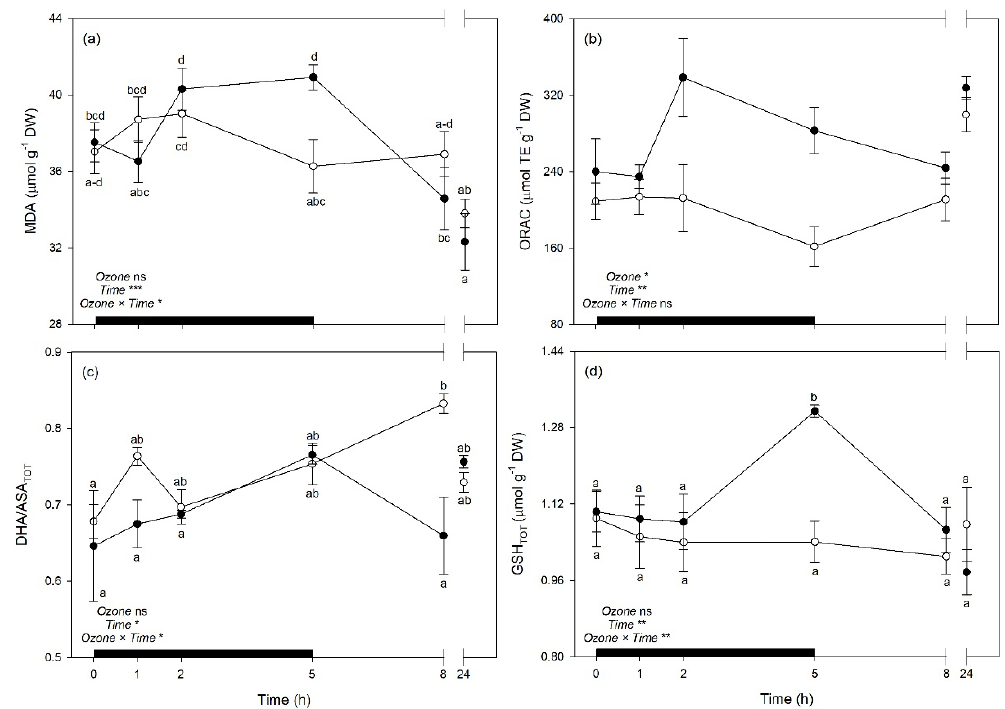
Figure 8. Time course of ( a ) malondialdehyde (MDA), ( b ) oxygen radical absorption capacity (ORAC), ( c ) oxidized:total ascorbate ratio (DHA / ASA TOT ), and ( d ) total glutathione (GSH TOT ) in sage plants exposed to charcoal-filtered air (open circle) or to 200 ppb of ozone for 5 h (closed circle). Data are shown as mean ± standard error. Measurements were carried out at 0, 1, 2, 5, 8 and 24 h from the beginning of exposure. p -Values for the e ff ects of ozone (between factor), time (within factor), and their interaction from a one-way repeated measures ANOVA are shown (*** p ≤ 0.001; ** p ≤ 0.01; * p ≤ 0.05; ns: p > 0.05). According to Tukey’s post-hoc test, di ff erent letters indicate significant di ff erences among means ( p ≤ 0.05). The thick black bar indicates the time of ozone exposure (i.e., 5 h). Table 4. F- and p -values of one-way repeated measures analysis of variance (ANOVA) for the e ff ects of ozone (between factor), time (within factor), and their interaction on spectral indices and leaf traits derived from sage spectra (only leaf traits from well performing PLSR-models were used: validation R 2 > 0.70 and 0.60 for gas exchange and biochemical traits, respectively). df represents the degrees